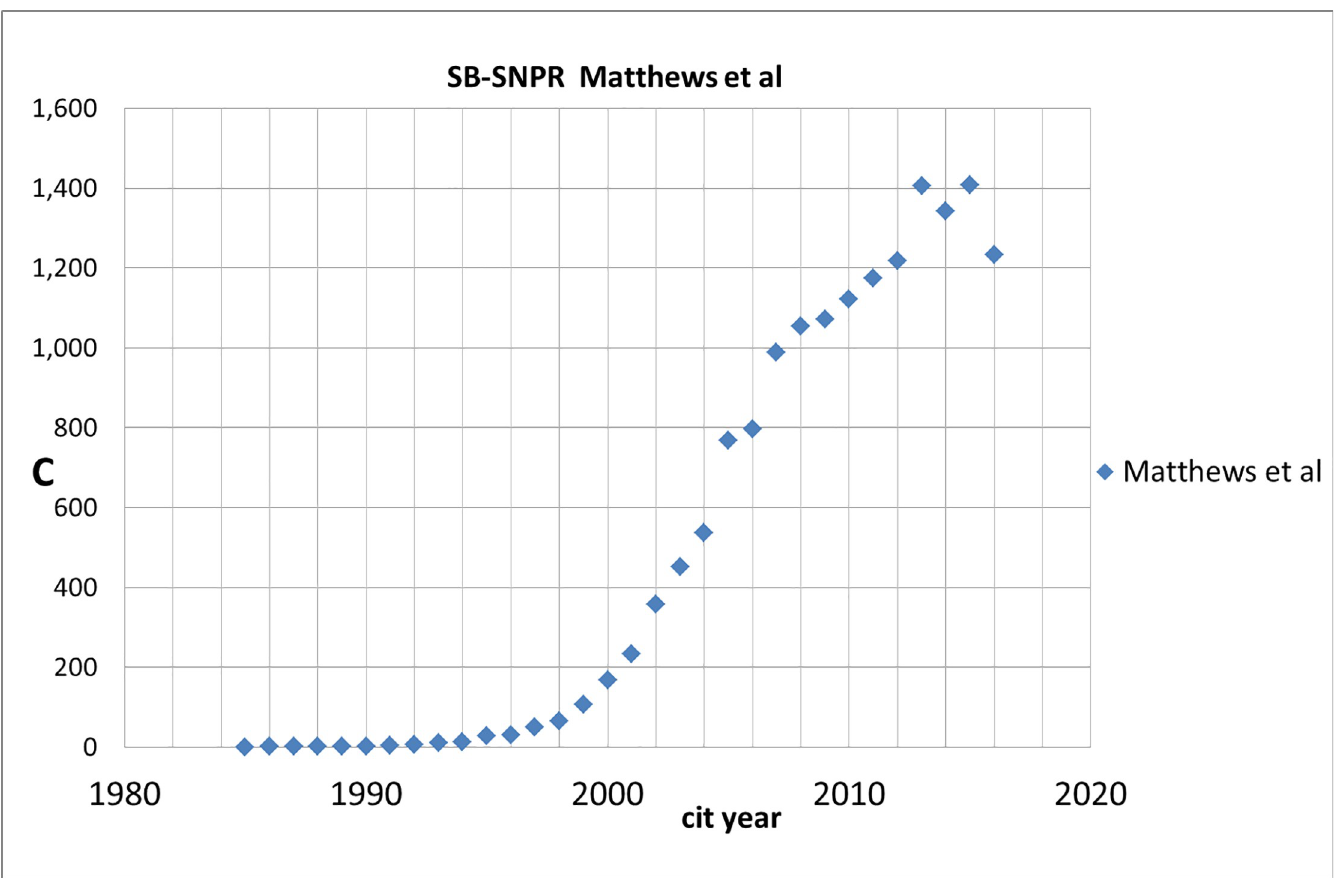
Fig 23. Trend in the number of citations received by the Matthews et al [24], an SB-SNPR published in 1985. On the abscissa the years of citation are given, on the ordinate the number of